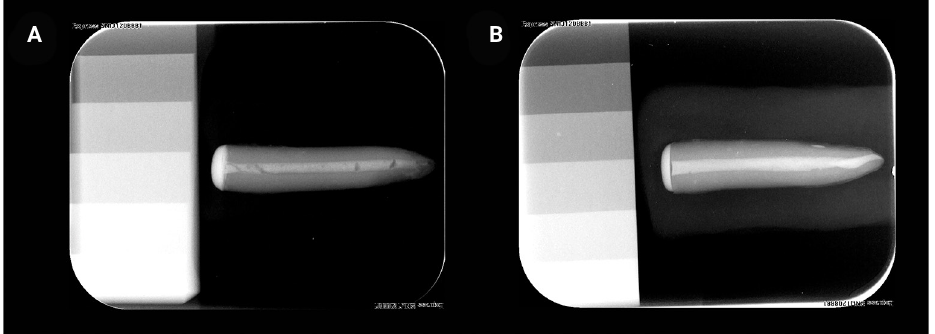
Figure 3. Examples of (A) inadequate score (2% chlorhexidine digluconate combined with Ca(OH) and (B) adequate score (Calen ® combined with zinc oxide) for the two parameters evaluated (sealing and